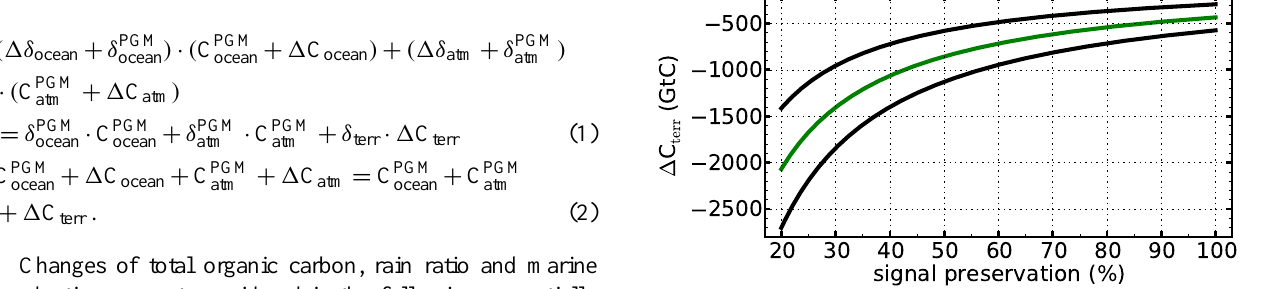
Fig. 4. Mass balance calculation for a potential change in terrestrial carbon storage from the PGM to the LGM: The plot shows the necessary carbon amount in GtC that has to be withdrawn (see Eq. 1) from the ocean-atmosphere system and transferred to the land carbon pool if δ 13 C atm shifted by 0.4‰ and mean ocean δ 13 C DIC changed by either 0.2‰ (top black line), 0.3‰ (middle green line) or 0.4‰ (bottom black line), respectively, between the PGM and the LGM dependent on the degree of isotopic attenuation due to the weathering influx (compare main text). The isotopic signature of peat biomass is assumed to be δ terr ∼− 28‰ . A signal preservation of 100% corresponds to no isotope attenuation.